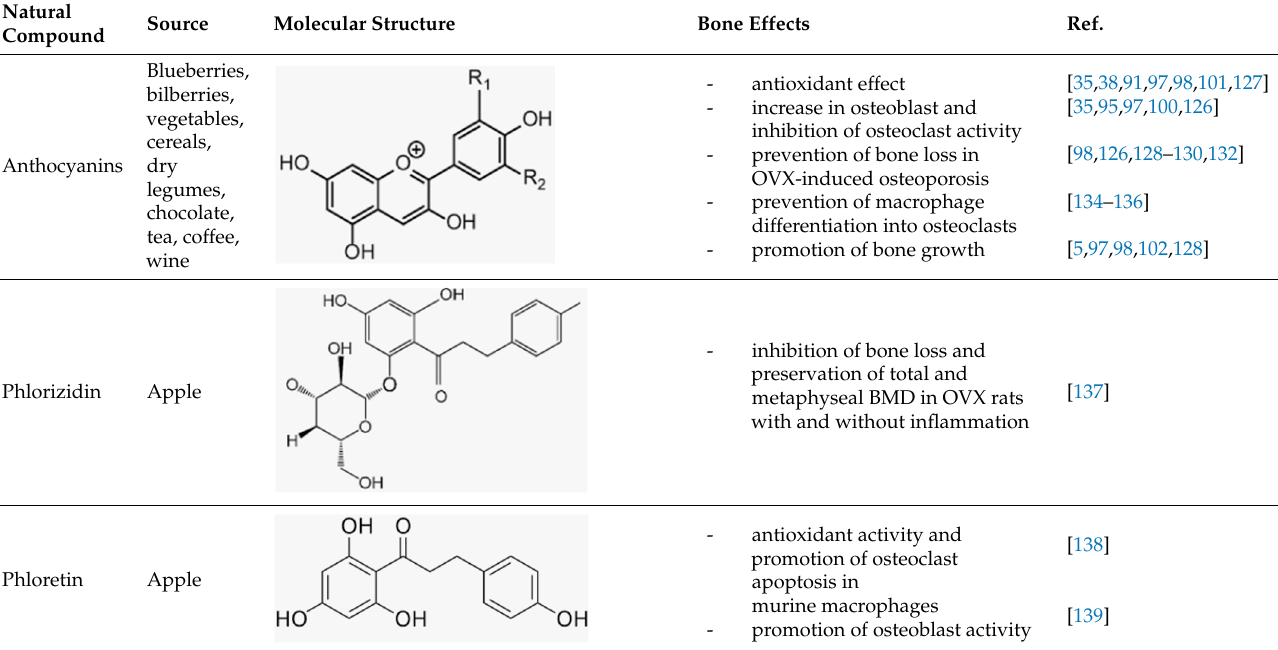
Table 2. Beneficial effects of natural antioxidants on bone metabolism.